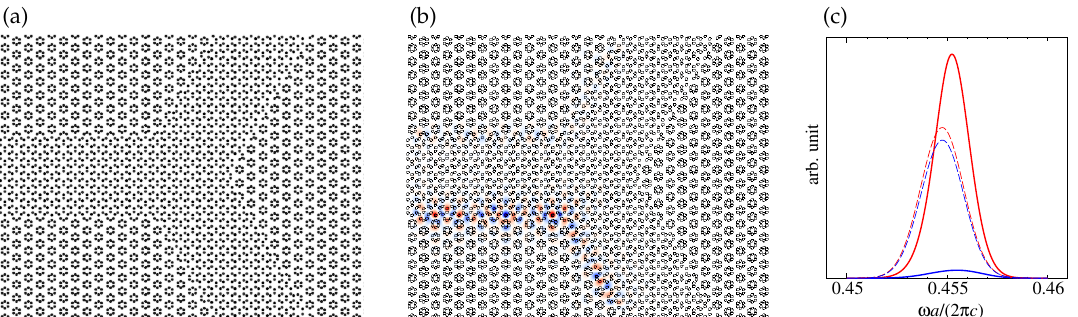
Figure 6. ( a ) Y-shaped waveguide composed of quasi-topological and non-topological photonic crystals in Figure 4. ( b ) z -component of electric field E z . ( c ) Spectra of the transmissions to the upper right (blue line) and lower right (red line) branches. The broken lines represent the transmission spectra for a vacuum Y-shaped